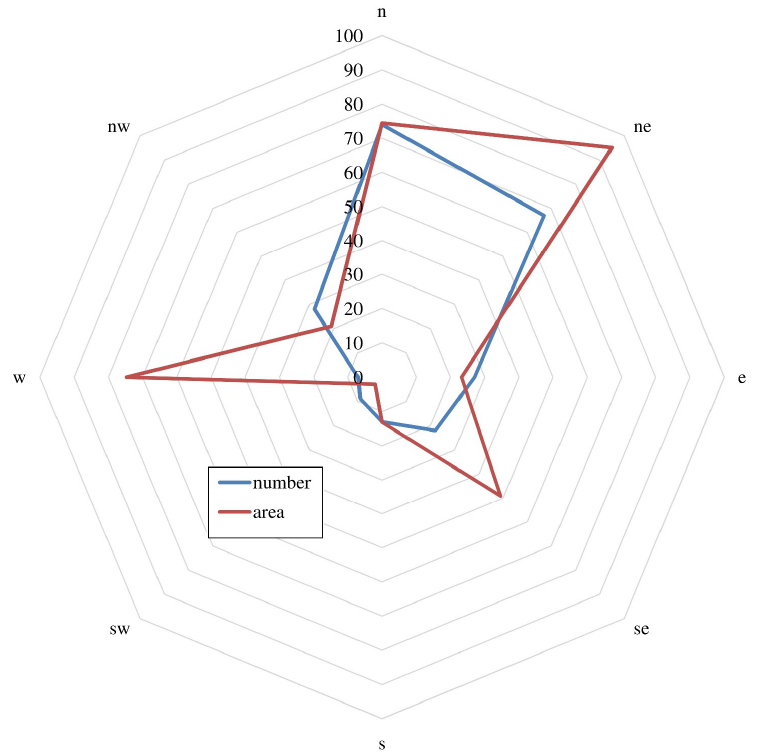
Figure 9. The aspect distribution of the number and area of glaciers at the peak of the LIA.